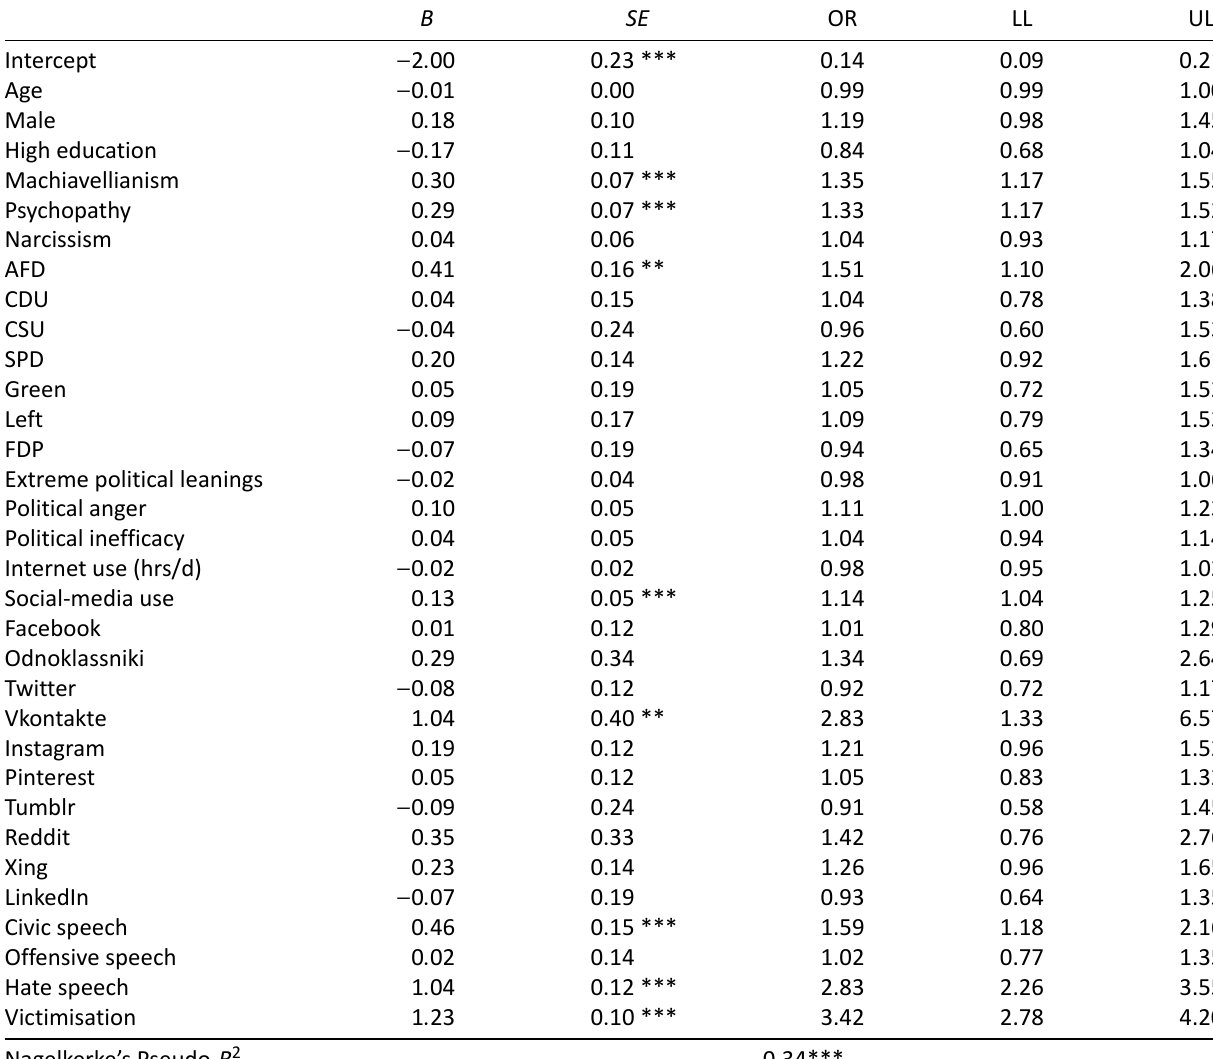
Table 4. Hierarchical logistic regression analysis, Block 6.